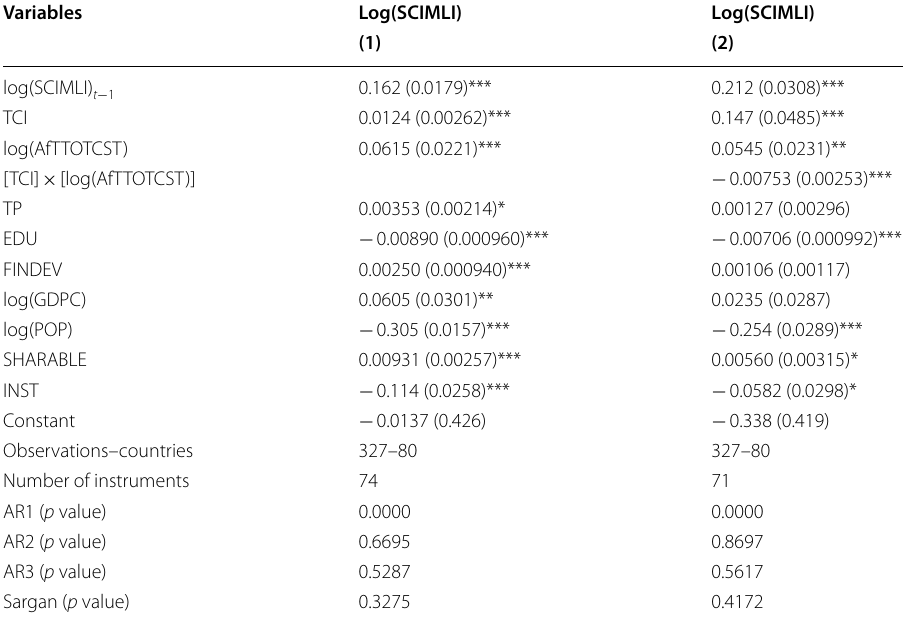
Table 5 Effect of the total AfT flows and development strategy on structural change in production